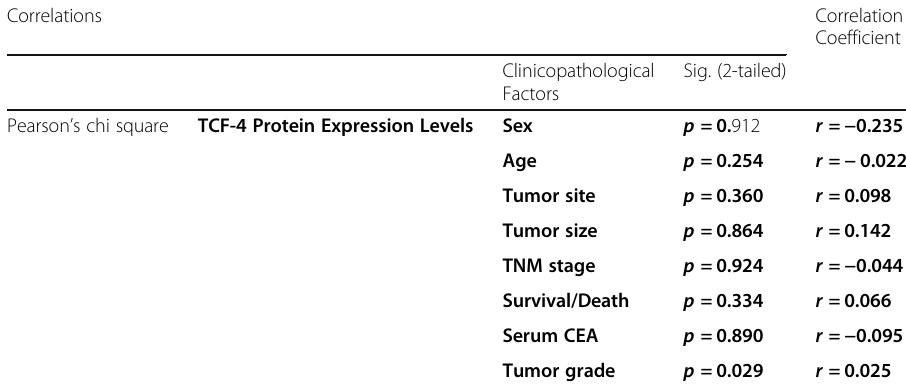
Table 8 Correlation of Clinicopathological factors with Protein Expression